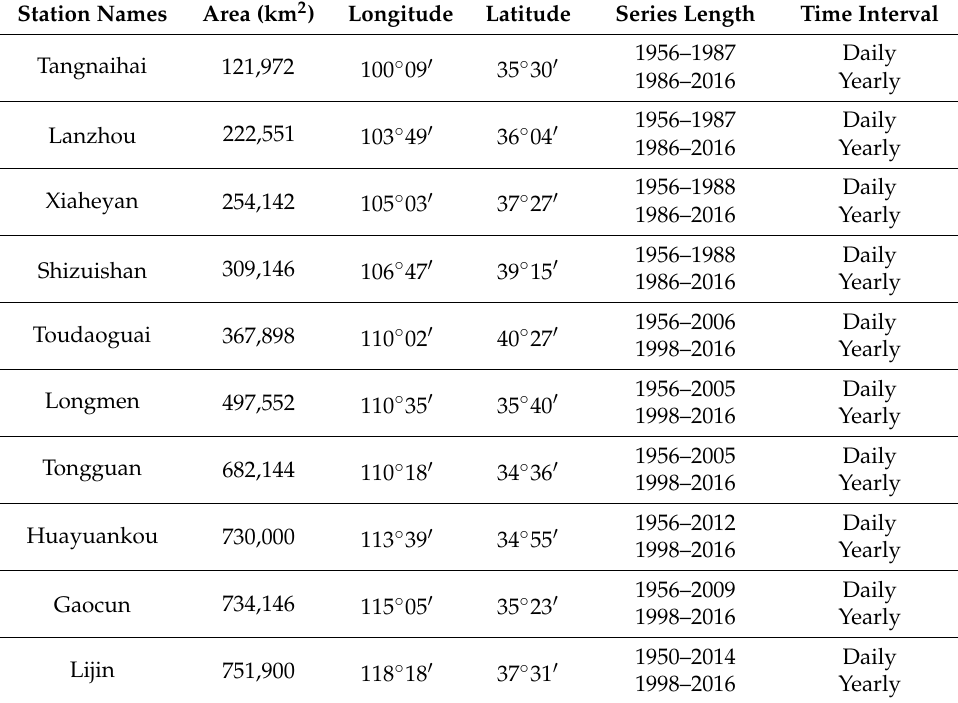
Table 1. Data information of ten hydrological stations along the Yellow